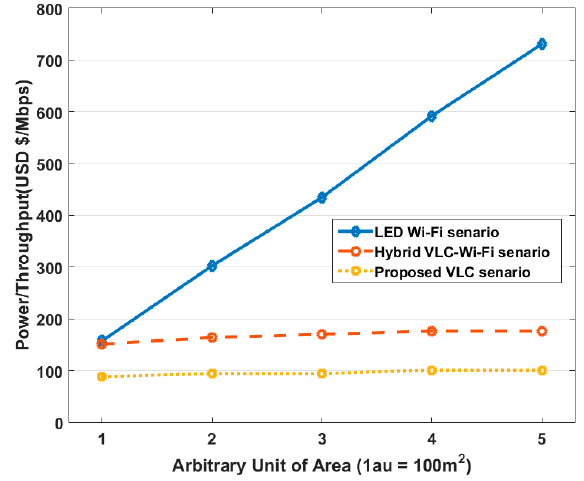
Figure 8. Power consumption cost comparison of architecture 1 for all three systems.